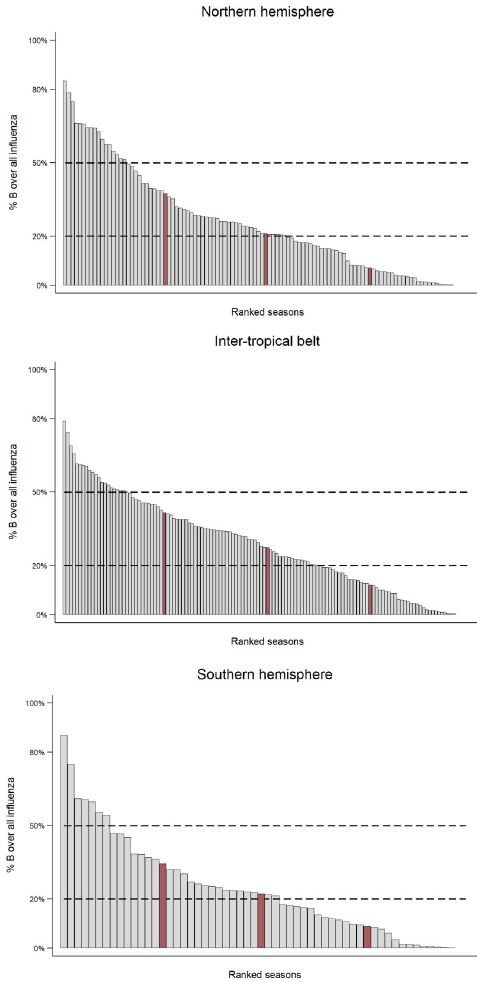
Global Influenza B Study,